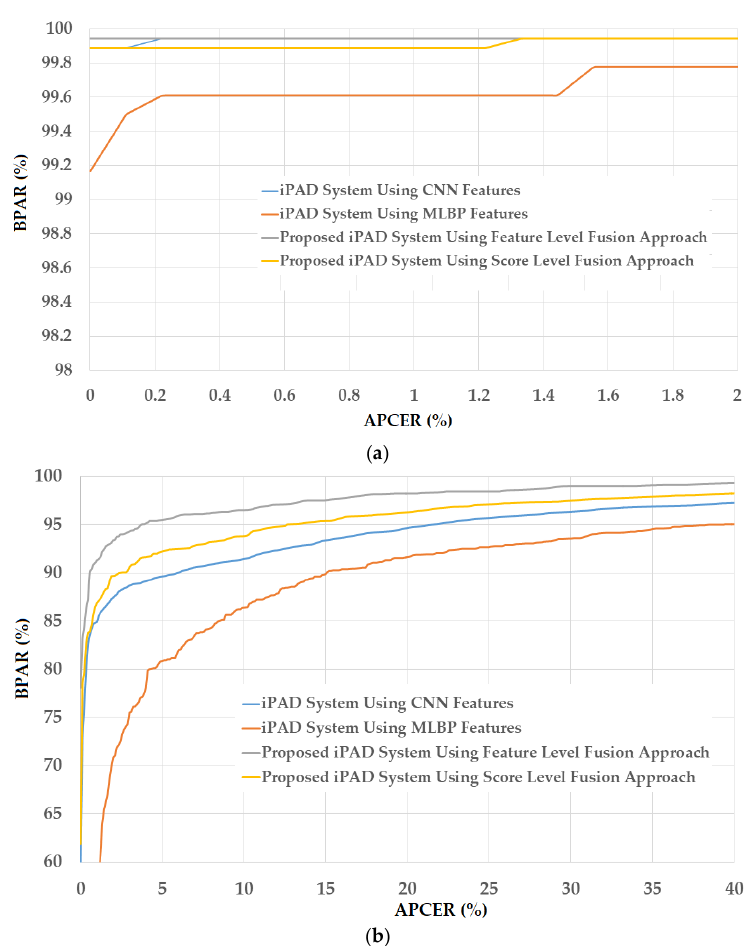
Figure 13. DET curves of iPAD systems based on use of CNN, MLBP, and hybrid image features (feature level fusion and score level fusion approach) using the first division method and ND2015 test-unknown dataset ( a ) DET curves of test-known dataset; and ( b ) DET curves of test-unknown dataset.